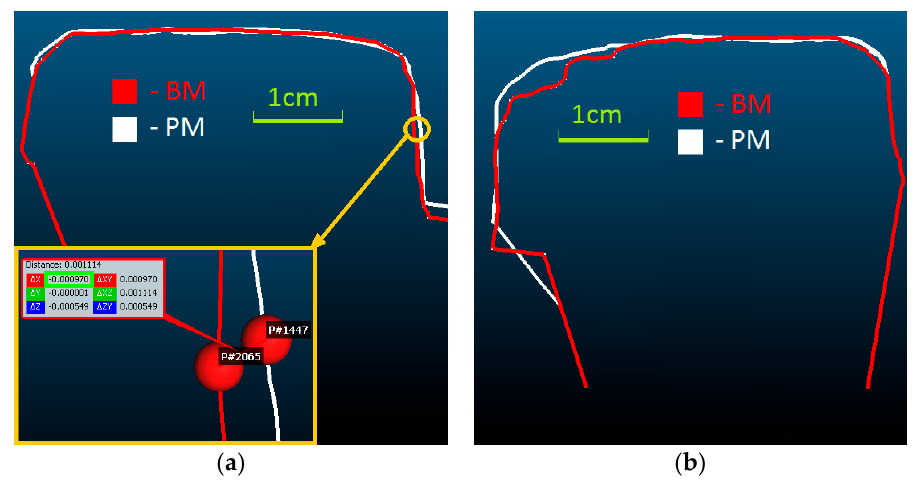
Figure 12. Discrepancies between cross-sections on the 3D models (BM and PM) ( a ) on the left; ( b ) on the right rail.